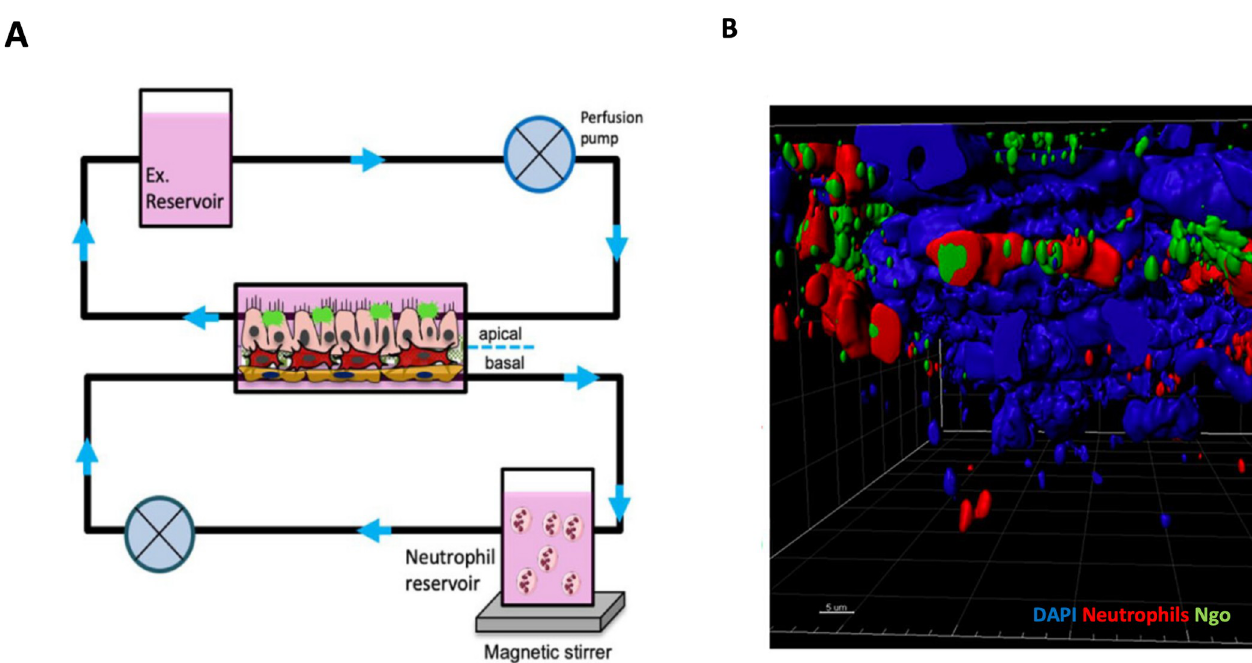
Fig 1. (A) Schematic of a perfusion-based bioreactor system that can be used for studying host–pathogen interaction as well as immune response to infection. This system is composed of a main chamber for holding the 3D human tissue model, an immune cell reservoir (neutrophils) and culture medium reservoir. (B) Reconstructed Z-stack of the confocal laser scanning microscopy images of an immunocompetent 3D human mucosa tissue model infected with Neisseria gonorrhoeae from the perfusion bioreactor system. (Adopted from Heydarian and colleagues AU : Pleasenotethatnumber 6 attheendofFig 1 captionhasbeenlinkedwithreferencenumber 6 ; andthecitationHeydarian ; SchweinlinhasbeenchangedtoHeydarianandcolleagues ; asperPLOSstyle : Pleaseconfirmthatthisiscorrect : [6]).